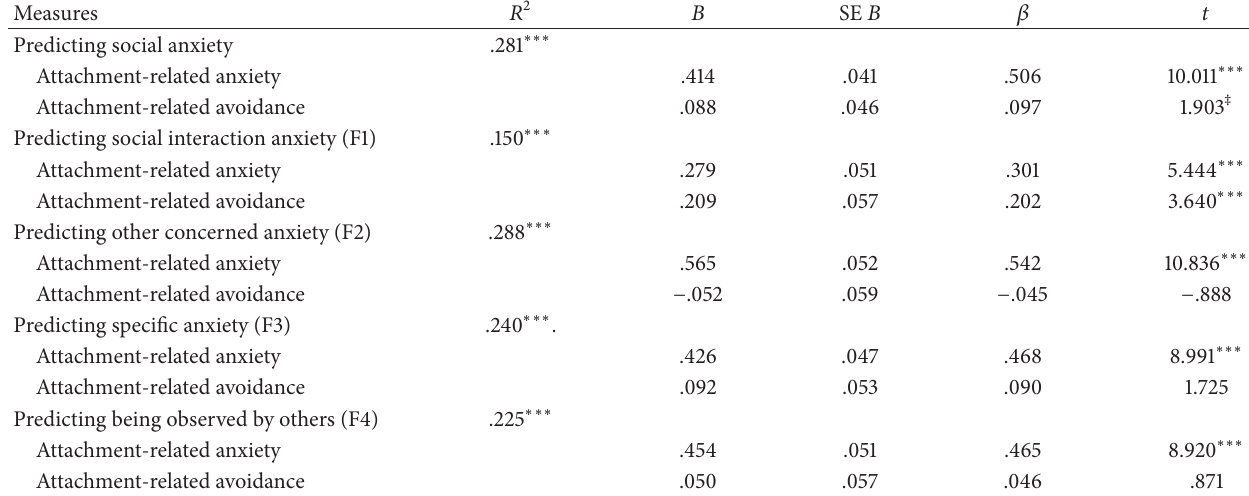
Table 3: Specificity of factors of attachment in predicting social anxiety and its four